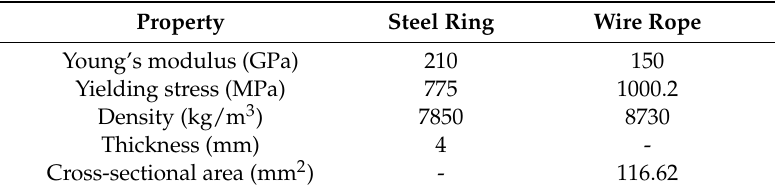
Table 1. Properties of 3-D FE